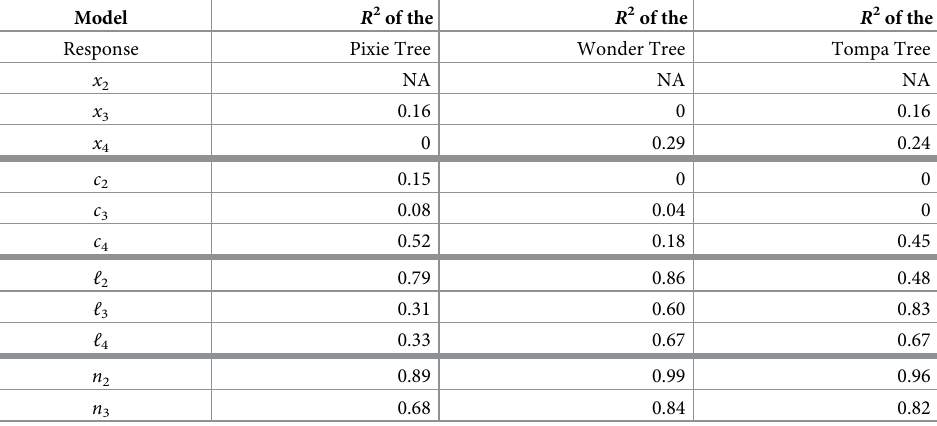
Table 5. The R 2 values for the selected modes of Table 4, including interaction effects presented in the supplemen- tary material. Model R 2 of the R 2 of the R 2 of the Response Pixie Tree Wonder Tree Tompa Tree